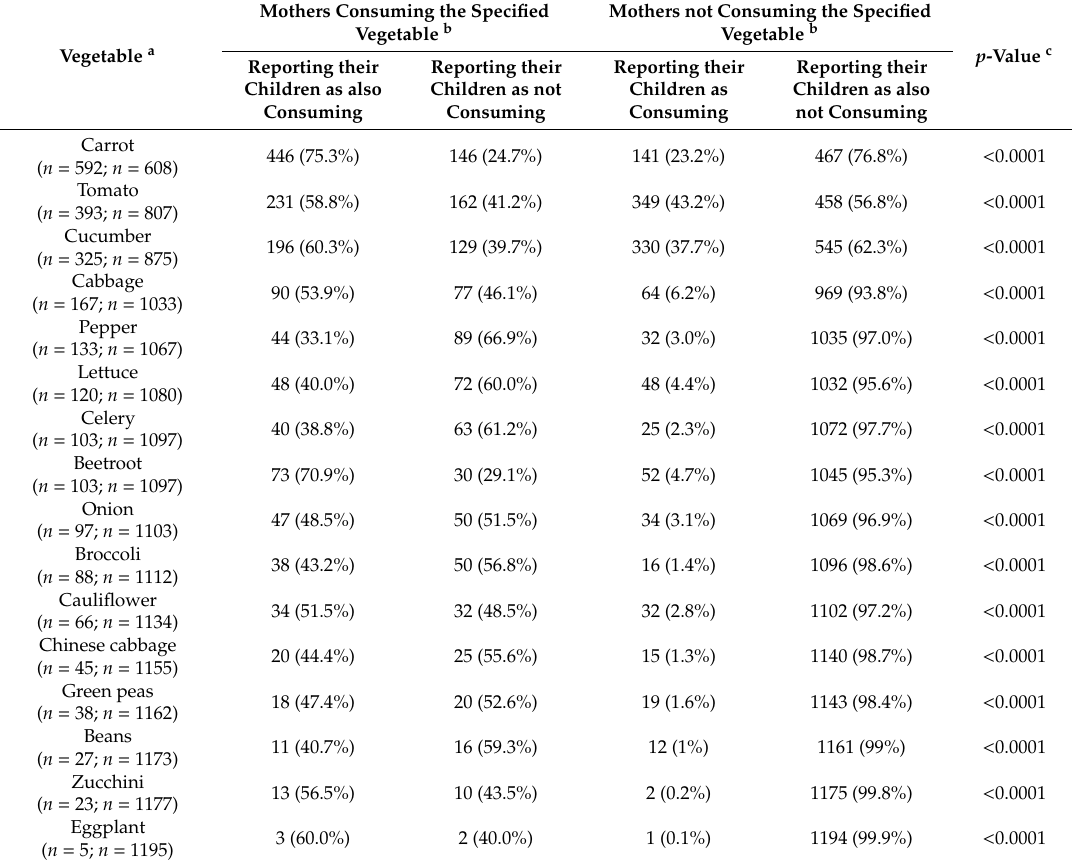
Table 3. Analysis of the association between the vegetable consumption behaviors self-reported by the mothers and reported by them for their children in a nationally representative sample of Polish mother–child pairs ( n =